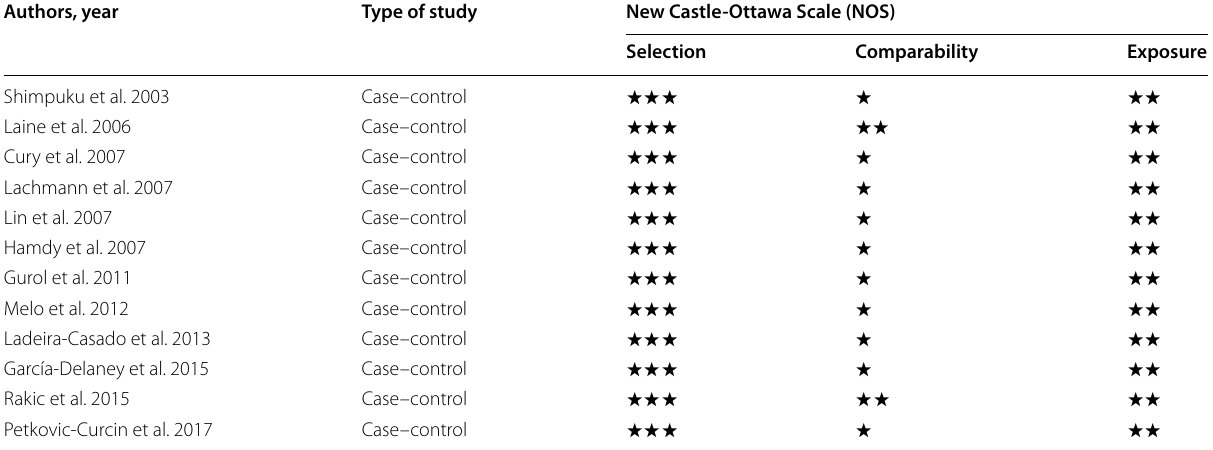
Table 2 Quality assessment of the included studies: NOS tool Authors,